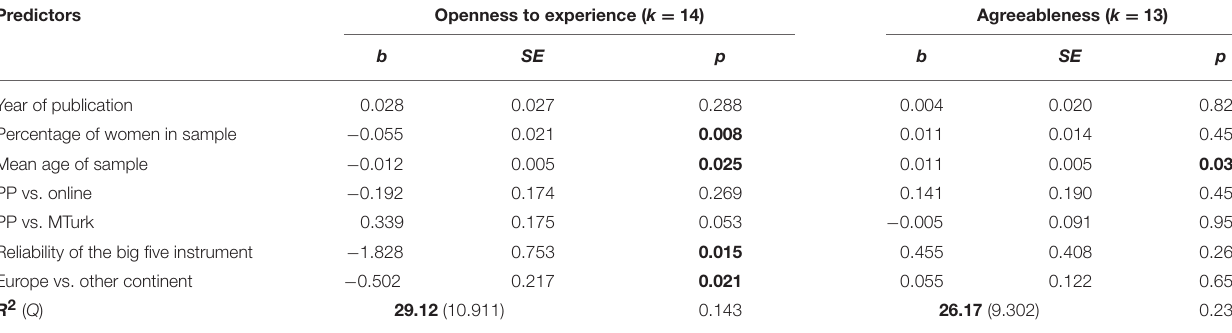
TABLE 3 | Parameters of mixed-effects meta regression on associations of openness to experience, agreeableness, and conspiracy beliefs.